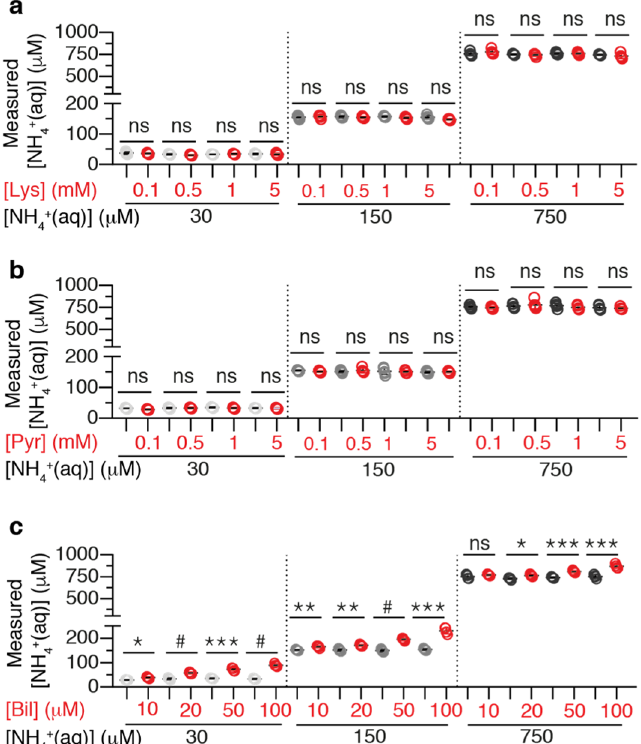
Figure 4. Analytical selectivity screening. Measured [NH 4 + (aq) ] in the absence (grey scale symbols) and presence (red symbols) of Lys ( a ), Pyr ( b ), and Bil ( c ) at various concentrations in solutions containing 30, 150, or 750 µM of NH 4 + (aq) in PBS. Results are shown as exact measured values and mean ± SD (n = 5 independently prepared QC replicates with or without interferent). Conditions: pH in 6.0, pH out 8.2, φ = 40 vol%, [HPTS] in = 1 mM, [HPTS] assay = 0.4 µM. For each interferent, Brown-Forsythe and Welch ANOVA (parametric; unmatched) statistical analysis was performed with Holm-Sidak’s multiple comparison tests, where ns, *, **, *** and # correspond to p > 0.05, p ≤ 0.05, p ≤ 0.01, p ≤ 0.001 and and p ≤ 0.0001, respectively.